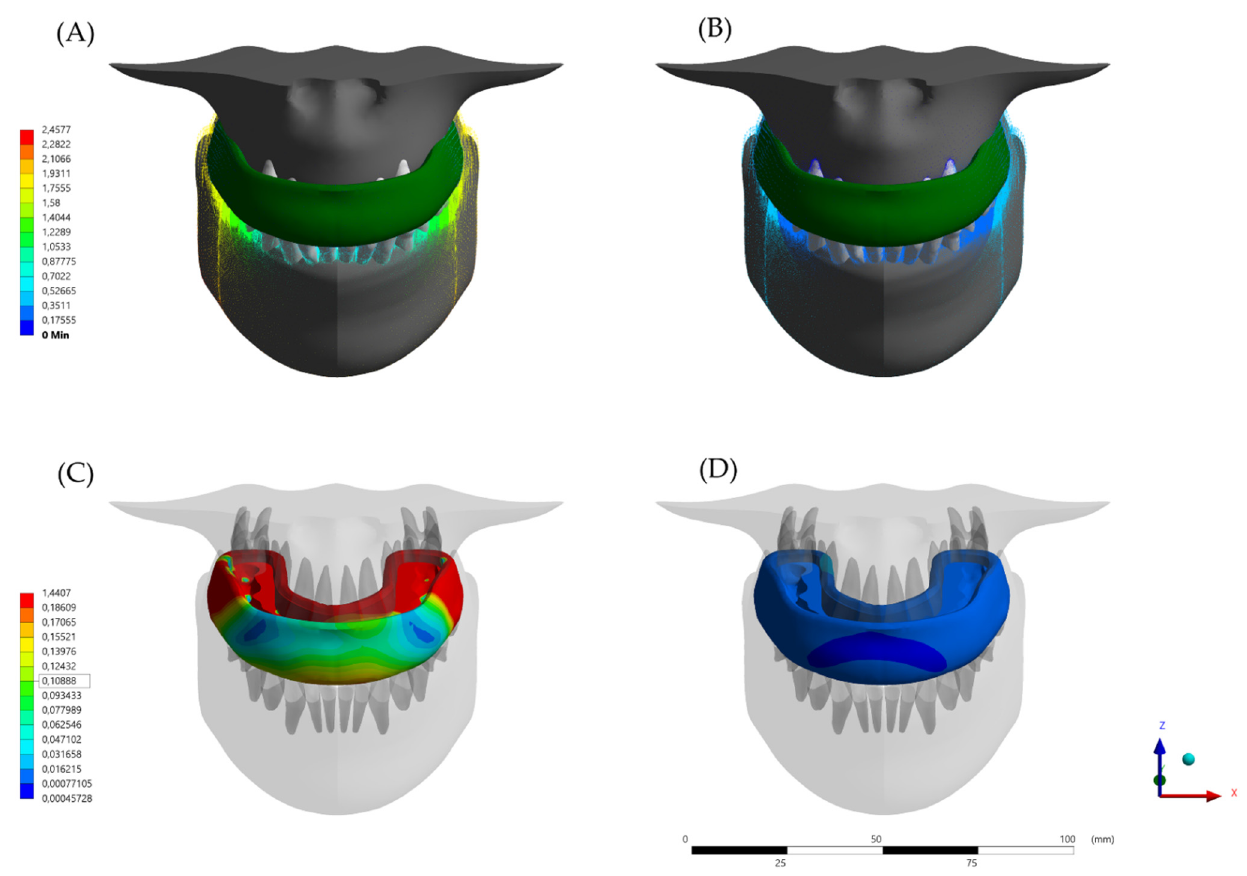
Figure 5. Total Deformation as displacement after the loading according to the different appliance designs. ( A ) Jaw displacement with the conventional (MG) design, ( B ) Jaw displacement with the hybrid (HMG) design, ( C ) Mouthguard device deformation with the conventional (MG) design, and ( D ) Mouthguard device deformation with the hybrid (HMG) design.